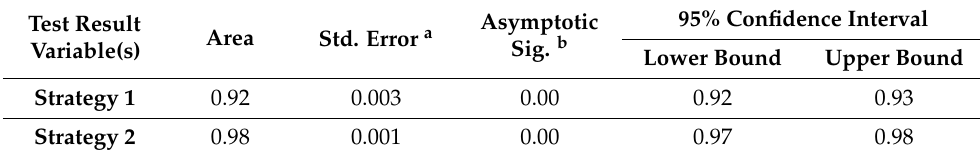
Table 7. Performance metrics to evaluate different water quality assessment